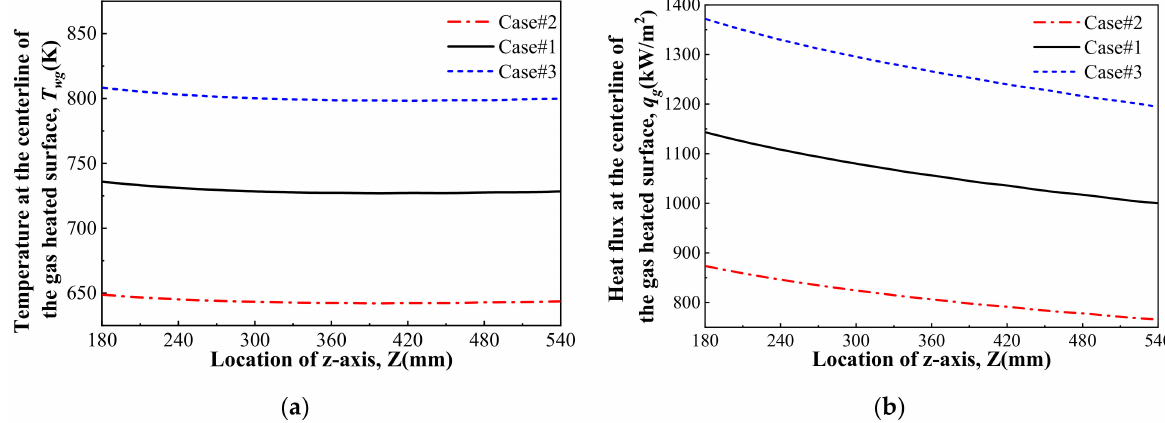
Figure 15. Variation of T wg and q g at the centerline of the gas heated surface with static pressures of gas: ( a ) T wg ( b ) q g . The heat transfer coefficient h g and Nusselt number Nu g of high-temperature gas at different static pressures is shown in Figure 16. As is shown in Figure 16a, h g increases with the static pressure of high-temperature gas, and declines along the flow direction. For static pressure of 50 kPa, 75 kPa and 100 kPa, the decline of h g along the flow direction is 12.7%, 13.1% and 13.6% respectively, which means the decline of h g along the flow direction increases with the static pressure of gas. The main reason may be that the density and viscosity of gas increases with the static pressure, which promotes the development of boundary layer, leading to a larger decline of h g . Figure 16b indicates that Nu g increases with the static pressure of gas. Besides, it can be seen that Nu g increases along the flow direction, and the increment of Nu g along the flow direction increases with the rise of static pressure.